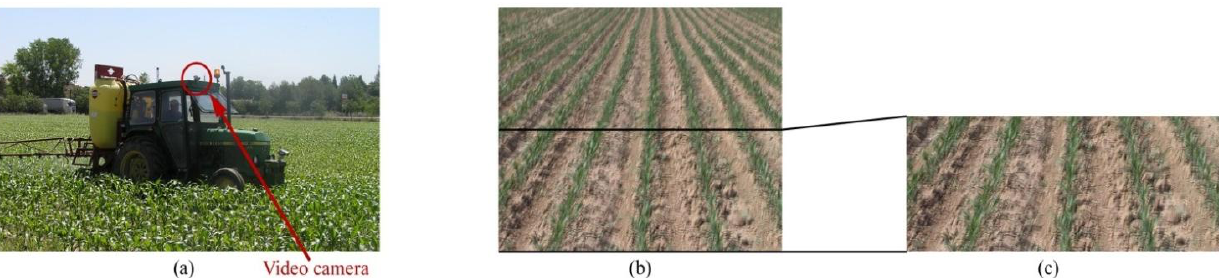
Figure 1. (a) The emplacement of the video camera onboard the tractor; (b) The original crop field image. Closer to the corners, crop rows become difficult to distinguish from one another; (c) Half of the original image, where crop rows are clearly